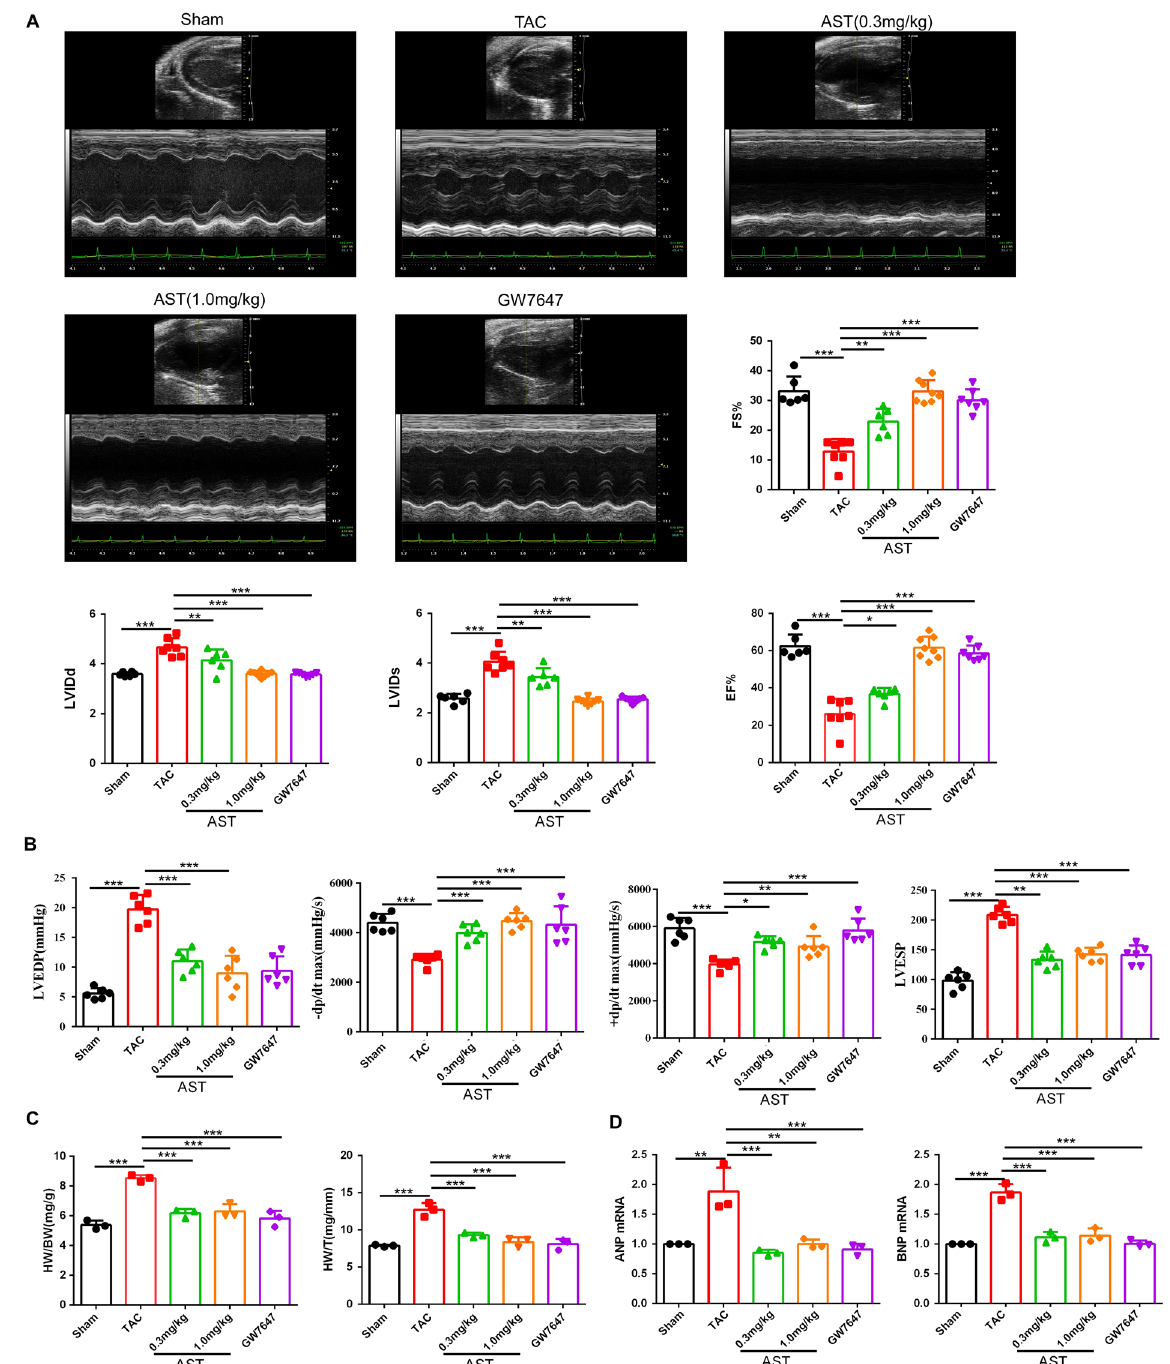
Figure 1. Astragaloside IV (AST) treatment exerted a protective effect that improved the contraction function in transverse aortic constriction-induced heart failure. ( A ) Representative M-mode echocardiography images. EF, ejection fraction; FS, fractional shortening; LVIDs, left ventricular internal systolic diameter; LVIDd, left ventricular internal diastolic diameter. Sham group (n = 6), transverse aortic constriction (TAC) group (n = 8), low dose AST (0.3 mg/kg; n = 9), high dose AST (1.0 mg/kg; n = 6), and GW7647 (1 µ g/g; n = 7). ( B ) The calculated hemodynamic parameters are shown as indices of heart function (LVESP, left ventricular end-systolic pressure; LVEDP, left ventricular end-diastolic pressure; ± dP/dt, rate of increase/decrease in maximum pressure). ( C ) Quantitation of heart-to-body weight ratio and heart weight-to-tibia length ratio. ( D ) Quantitative real-time polymerase chain reaction analysis of ANP and BNP expression. * P < 0.05, ** P < 0.01 and *** P < 0.0001. Data are mean ±